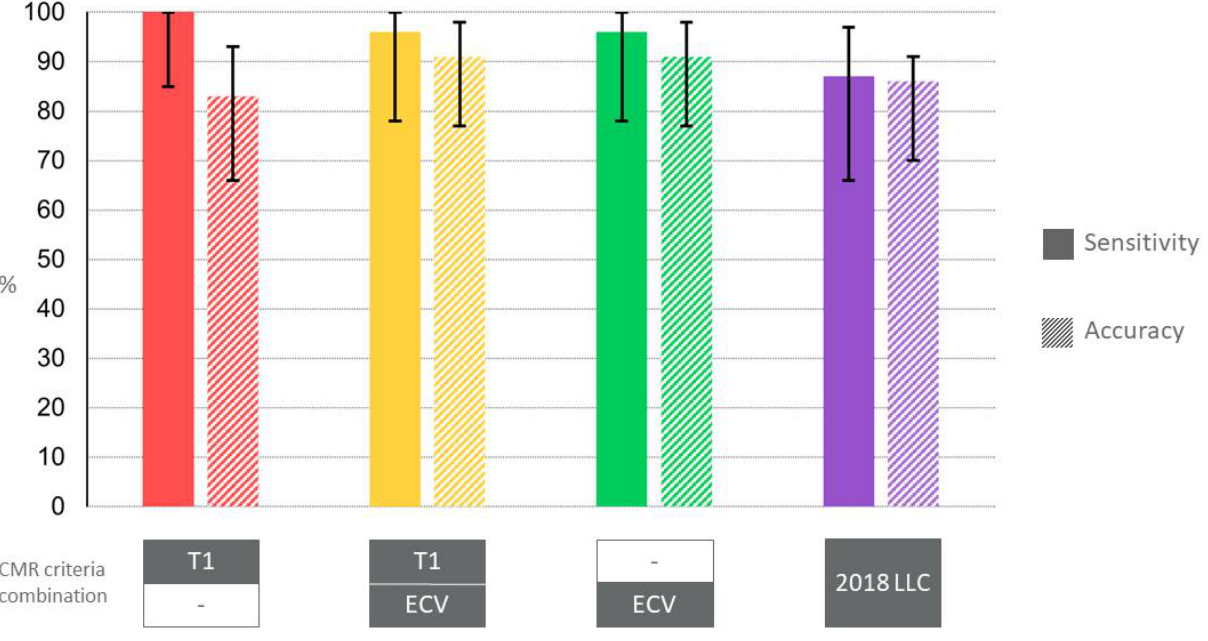
Figure 2. Diagnostic Performance of CMR Criteria Combination for Discrimination of Subacute Myocarditis from Healthy Controls. The best diagnostic performance in the detection of subacute myocarditis and the discrimination from healthy controls was achieved by both ECV evaluation alone or in combination with T 1 mapping, demonstrating a sensitivity of 96% (CI 78–100) and an accuracy of 91% (CI 77–98). A segmental or global increase of native T 1 > 1015 ms and ECV > 28% was applied, derived from ROC analysis. LLC = Lake Louise criteria.